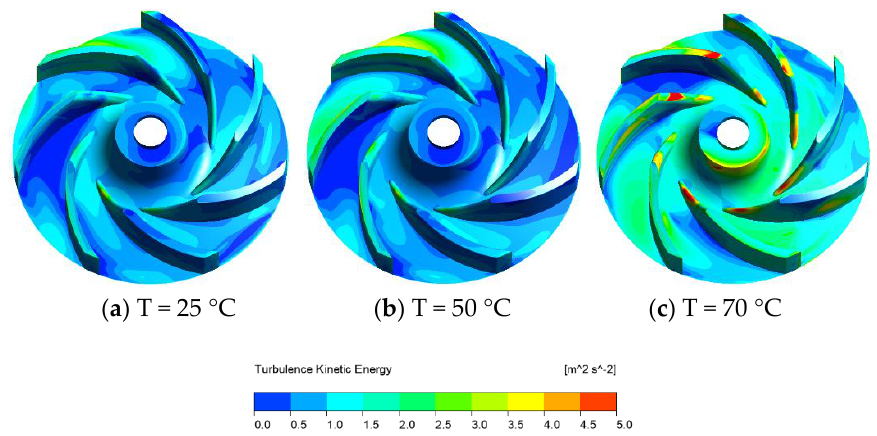
Figure 16. Turbulence kinetic energy distribution with different temperatures based on the same